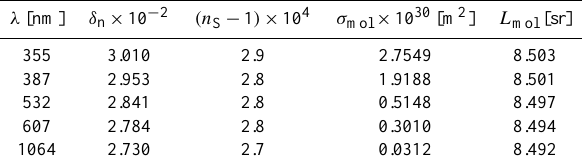
Table 2. Numerical values of the parameters involved in Eqs. (9) and (10) calculated for the most common lidar wavelengths accord- ing to Bucholtz (1995). The quantity δ n represents the molecular de- polarization factor for unpolarized (natural) incident light scattered at right angle, n S is the refractive index of standard air, L mol the molecular lidar-ratio, and σ mol the total Rayleigh-scattering cross section per molecule given by Eq. (9) when ρ mol = 1, and a value of ρ S = 2 . 54743 × 10 25 m − 3 for the molecular number density for standard air in Eq. (9) is